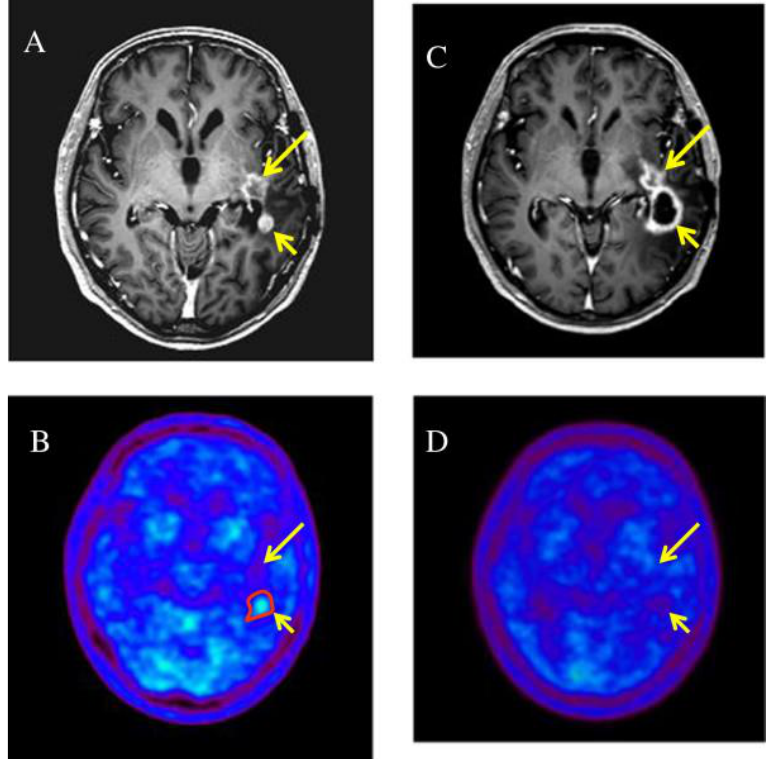
Figure 3. Two enhanced lesions (long and short arrow) were demonstrated in the left temporal lobe on T1-weighted magnetic resonance imaging ( A ), MET-PET demonstrated a MET high-uptake on the region of short arrow ( B ), only the enhanced lesion (short arrow) was treated with RT; 5 months later it was increased in size ( C ) but not in uptake ( D ) (suggestive of pseudoprogression) while the non treated lesion remained stable [58].